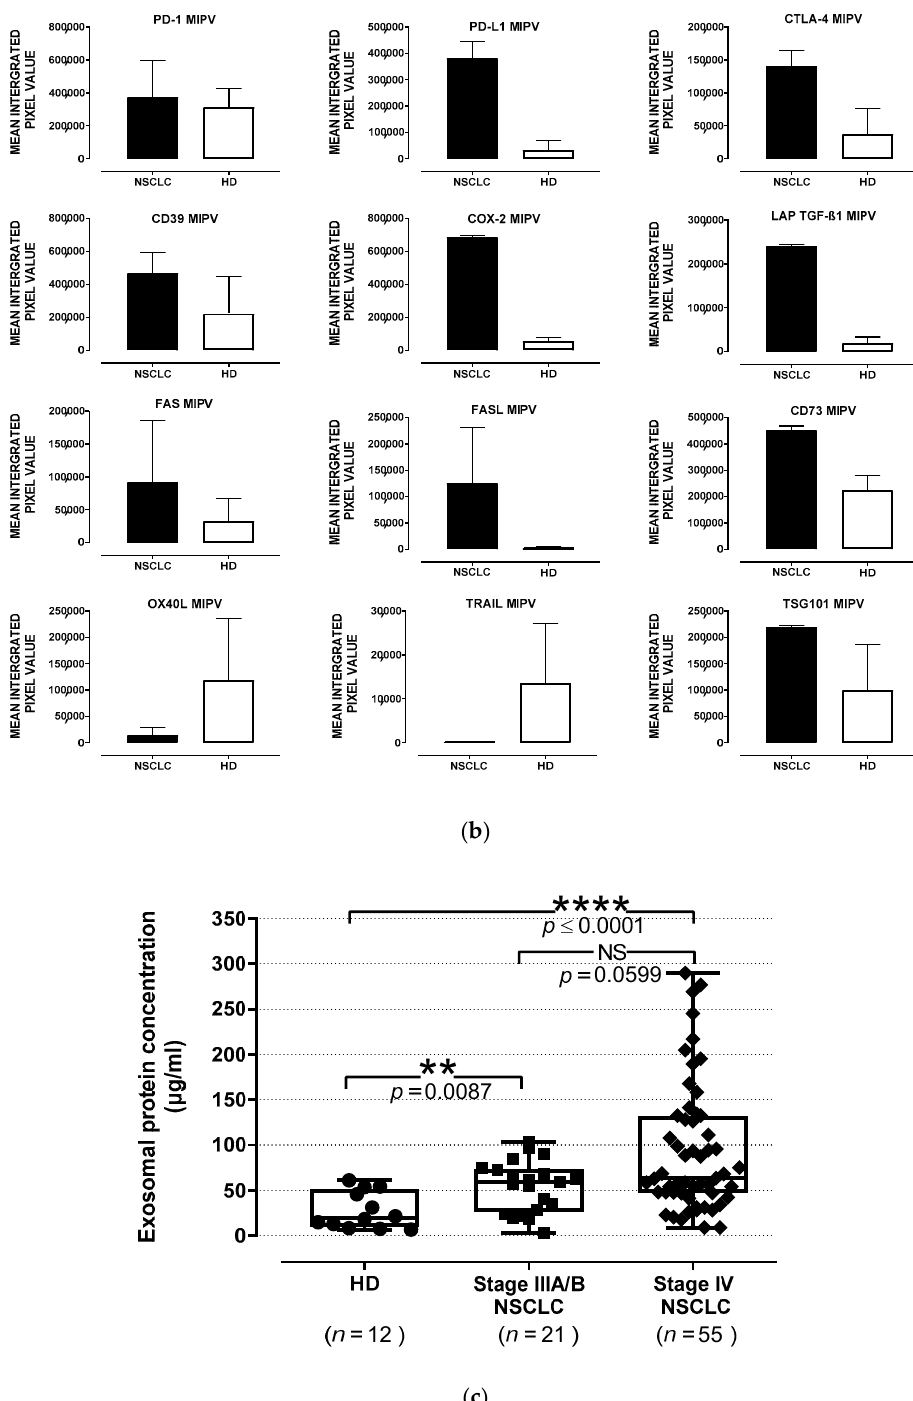
Figure 2. Molecular content and baseline protein levels of sEV isolated from NSCLC plasma. ( a ) Representative Western blot (WB) of sEV isolated from the plasma of NSCLC or HD. Each lane of the WB contained 10 µ g exosomal protein. ( b ) Semi-quantitative densitometry of the Western blots as described in Methods. The bars denote mean values ± SEM. (open bars = HD, n = 2; closed bars = stage IV NSCLC patients, n = 2). ( c ) The exosomal protein levels ( µ g/mL plasma) in patients were higher compared with HD. Each point corresponds to an individual patient or HD (black circles = HD, black squares = stage IIIa/b NSCLC patients, black rhombus = stage IIIa/b NSCLC patients). The medians, 75th percentile (box), and maximum and minimum (whiskers) are represented. Groups were compared using the Mann–Whitney U test (HD vs. stage IV; stage IIIA/B vs. IV) and unpaired t -test (HD vs. stage IIIA/B). ( n : number of patients; NSCLC: non-small-cell lung cancer; HD: healthy donor; **, p < 0.01; ****, p < 0.0001; NS: